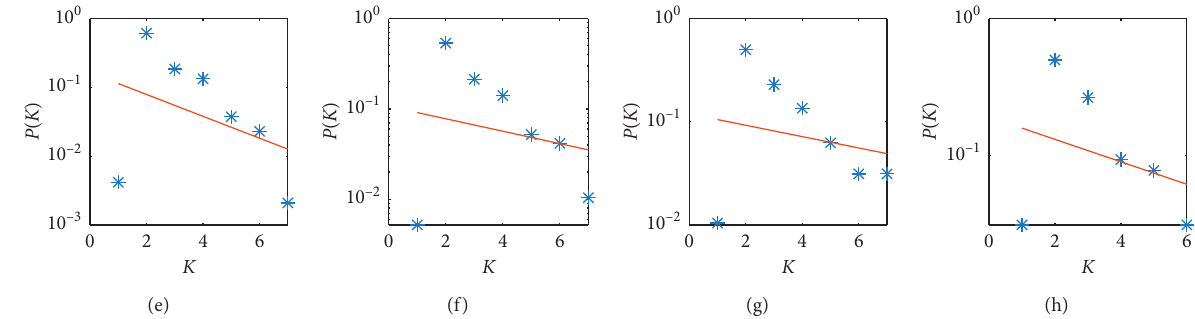
Figure 13: Results after power law distribution and exponential distribution fitting. (a) Δ t � 2min. (b) Δ t � 5min. (c) Δ t � 10min. (d)